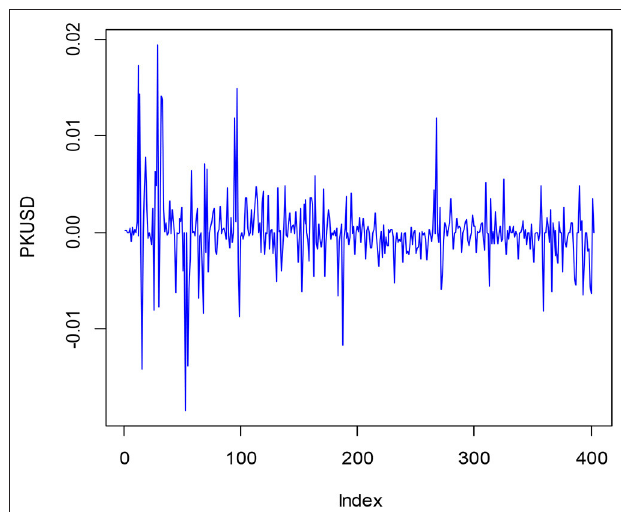
FIGURE 4 | PKUSD data after